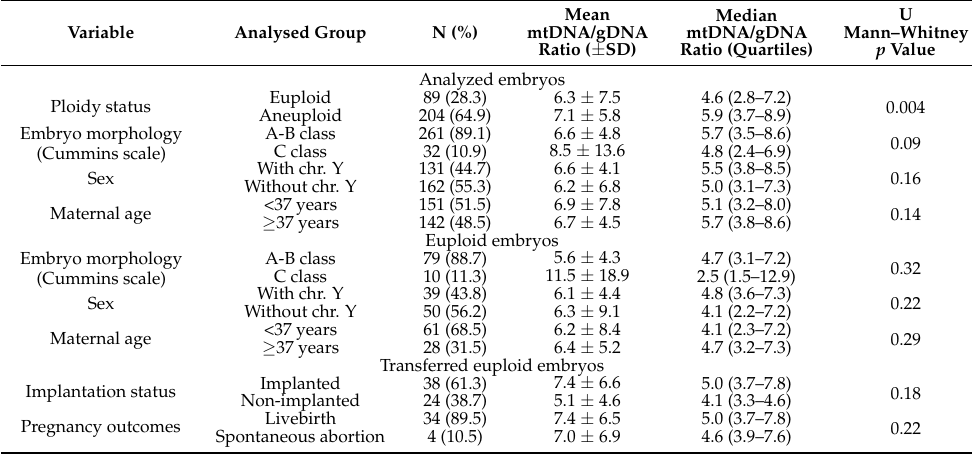
Figure 2. Boxplot (median, hinges: first and third quartiles) showing mtDNA/gDNA ratios obtained for aneuploid and euploid groups of analyzed embryos. NGS analysis of 293 blastomeres showed a statistically significant increase ( p < 0.004) in the mtDNA levels occurring in the presence of aneuploidy status. Table 2. The mtDNA/gDNA ratios for all comparison groups.